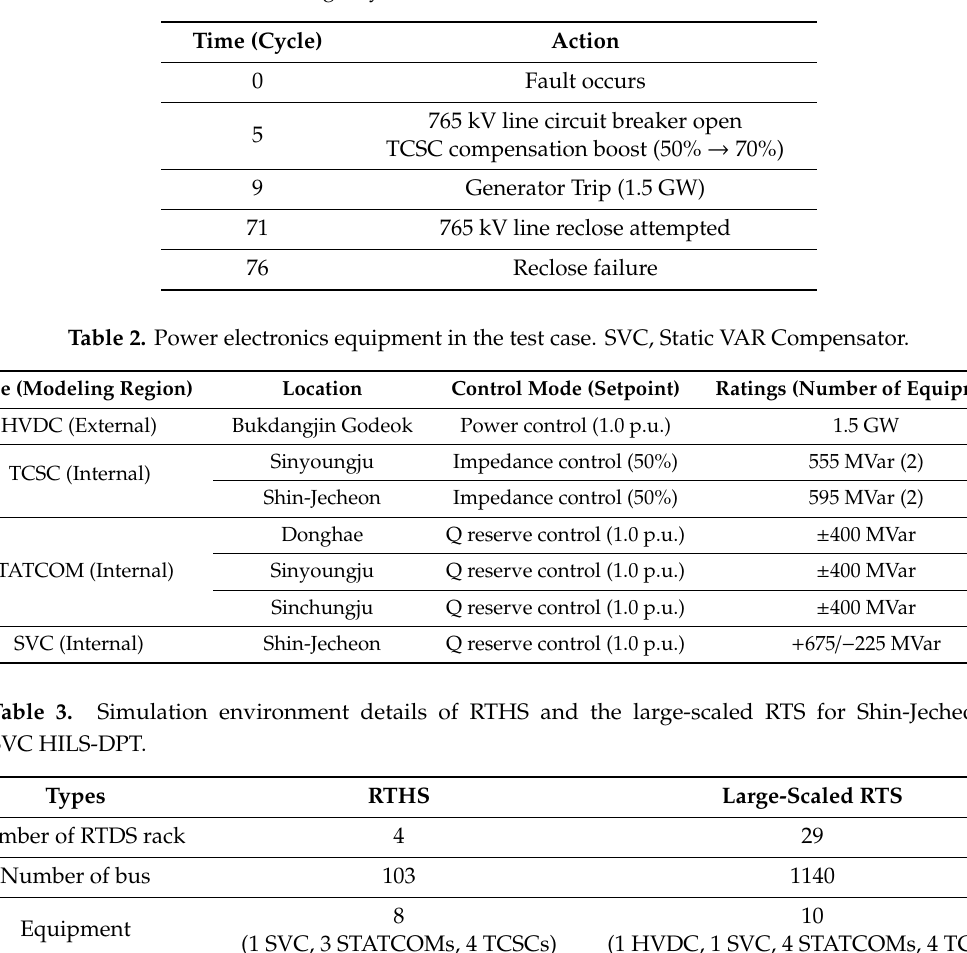
Table 1. Contingency scenario for 765 kV transmission line fault.